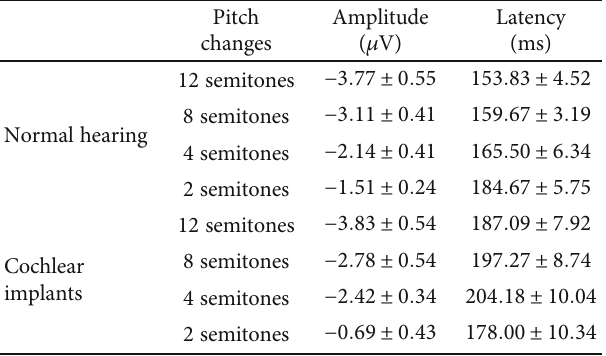
Figure 1: Grand-average MMN waveforms for distinct pitch di ff erences for NH listeners (a) and CI users (b) at electrode Fz. Gray shading indicates time windows used to calculate amplitudes and latencies ((a) 130 – 210 ms; (b) 156 – 236ms). Table 3: Statistical results of the MMN amplitude and latency ( average ± standarddeviant ) for 12-semitone, 8-semitone, 4- semitone, and 2-semitone pitch changes in NH listeners and CI